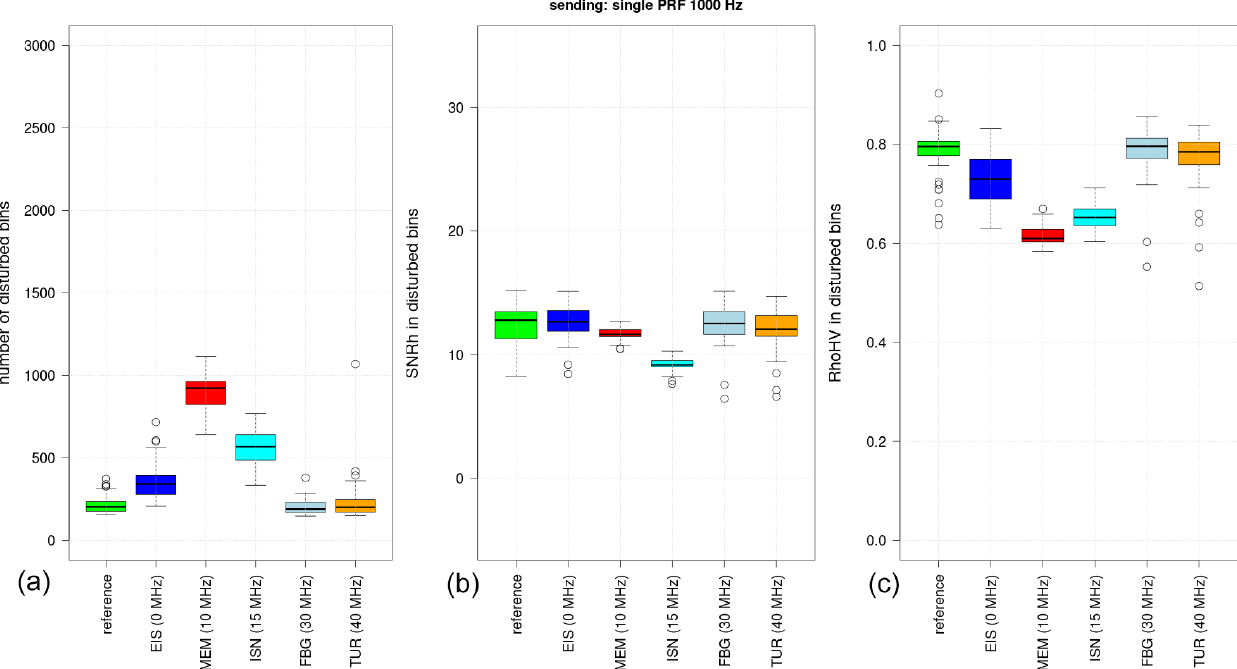
Figure 7. Boxplot of the number of disturbed bins (a) , the SNR in these pixels (b) and the RhoHV in these pixels (c) during the first period as described in Sect. 3.2. The values behind the radar names give their difference in sending frequency relative to the MHP radar.